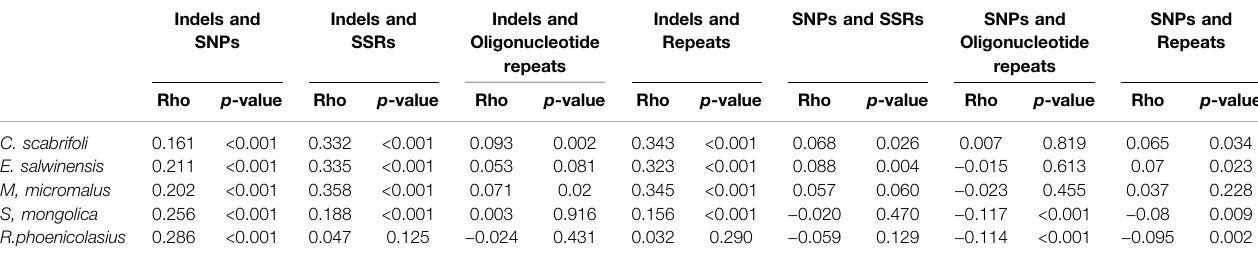
TABLE 3 | Correlation values of indels with SNPs, indels with repeats and SNPs with repeats. Indels and